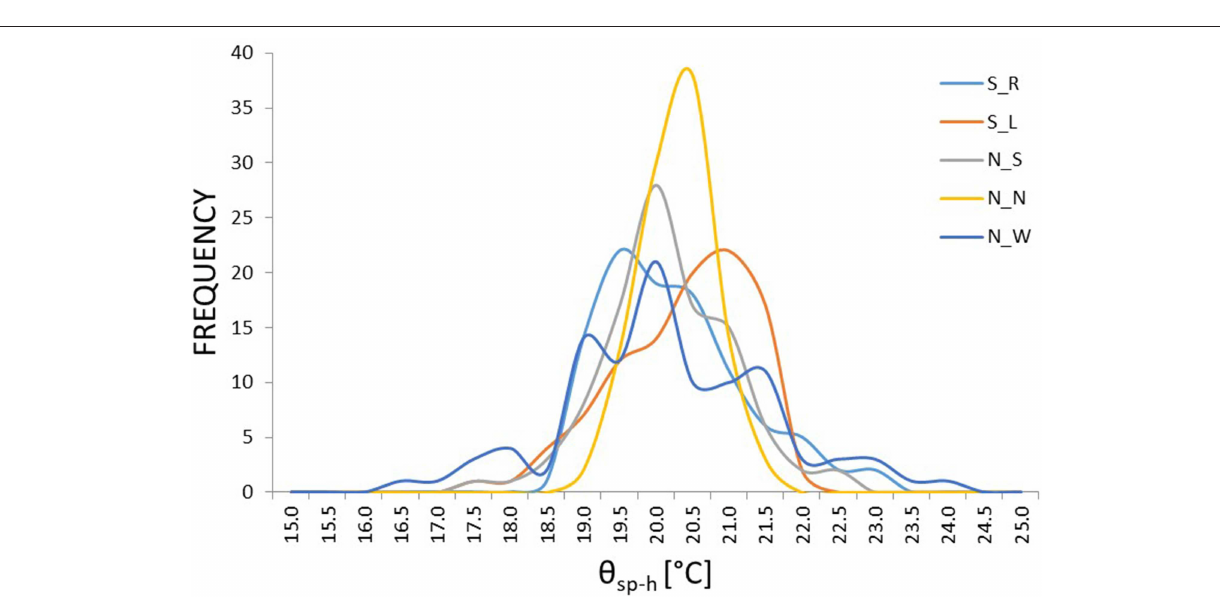
Frontiers in Energy Research |